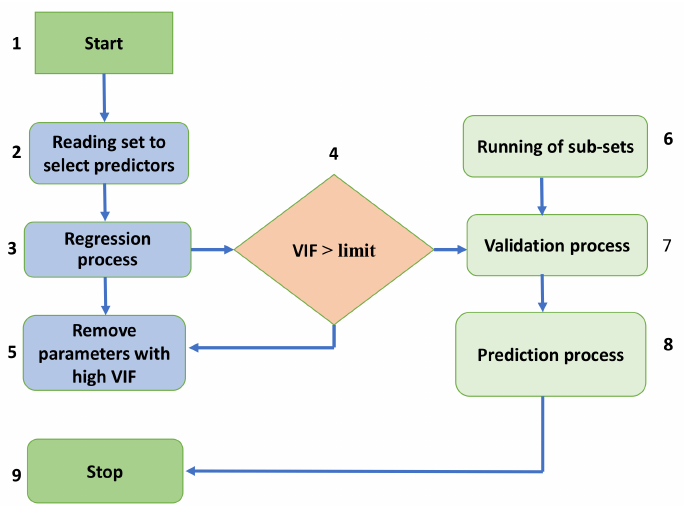
Figure 4. Flow chart of the MLP model showing the complete execution process.